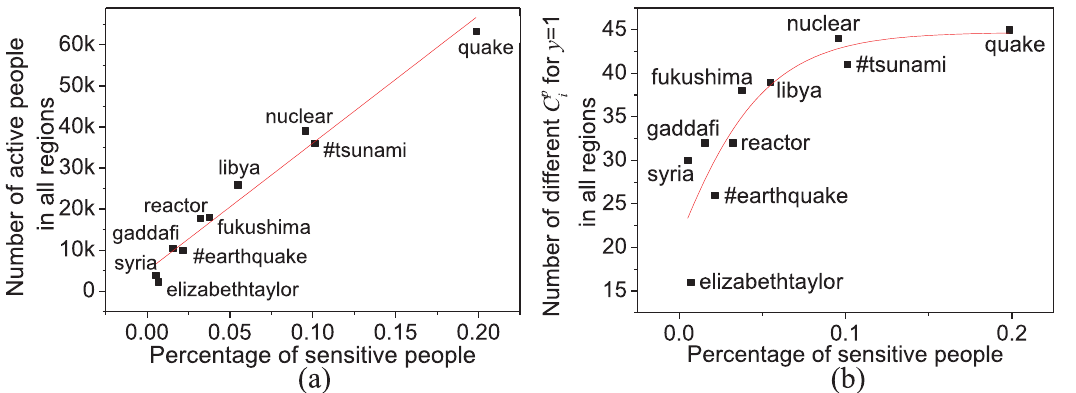
Fig 4. Heterogenous regional responses measured by the sensitive people. (a) The positive relationship between the percentage of sensitive people and the total amount of active people who has posted a tweet about a certain event at least once. (b) The nonlinear relationship between the percentage of sensitive people and the number of different C p i in all regions. The more people take part in the discussions about an event, the more heterogeneity of people will appear that cause the diversity of human responses as shown in Fig H in S1